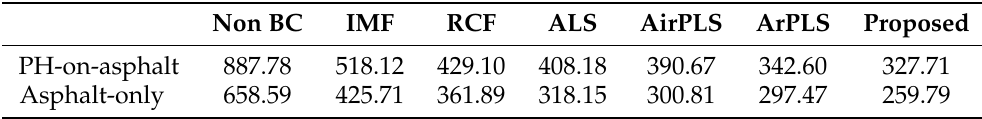
Table 3. RMSME averages of 500 PH-on-asphalt spectra and 1600 asphalt-only spectra for baseline correction